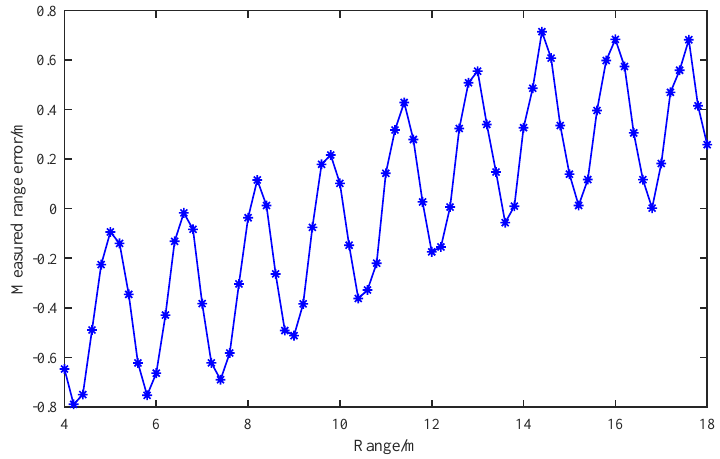
Figure 11. Measured range error under different